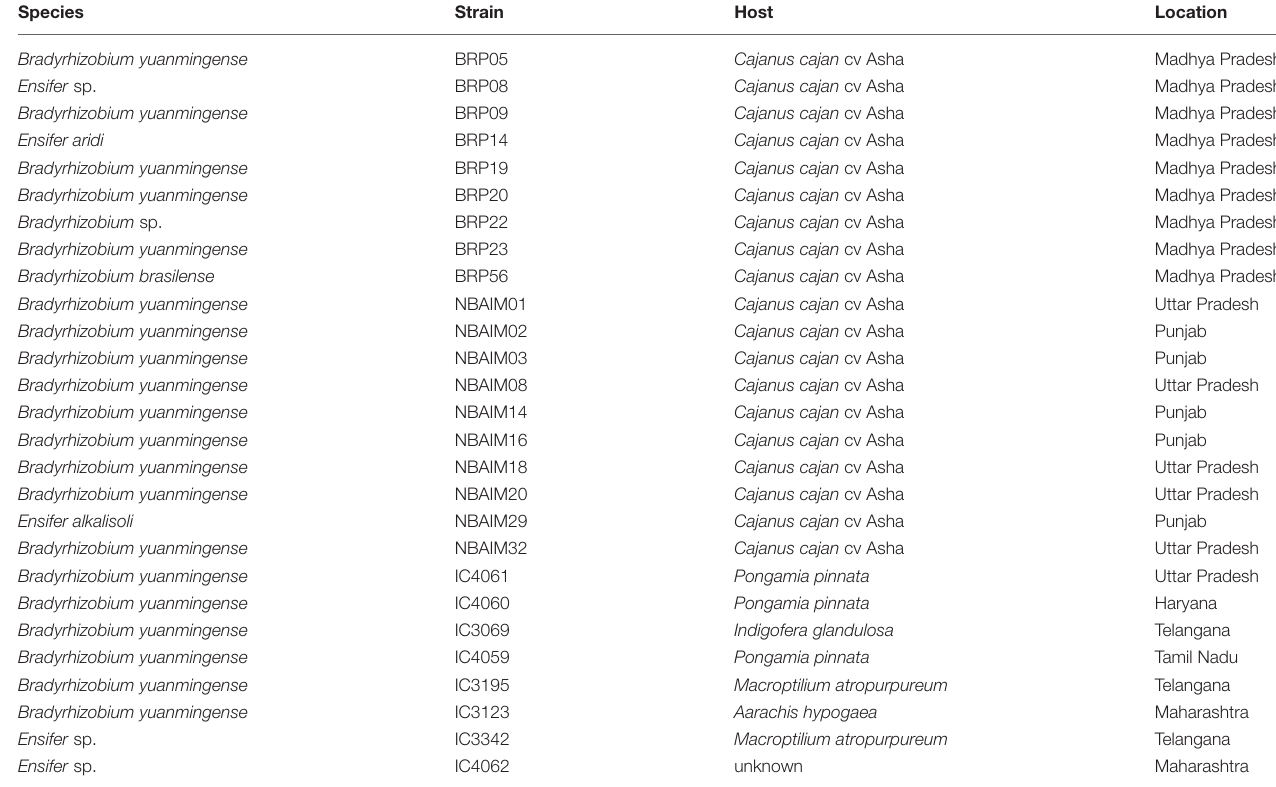
TABLE 1 | Strains sequenced and used for genomic comparison. Species Strain